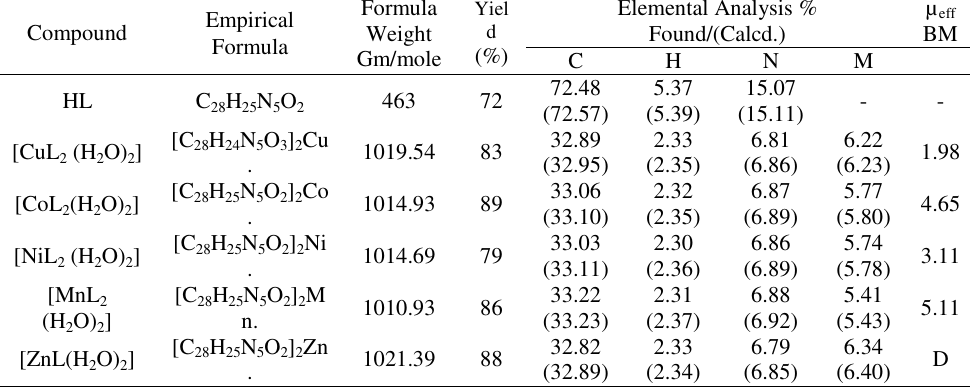
Elemental Analysis % Found/(Calcd.)